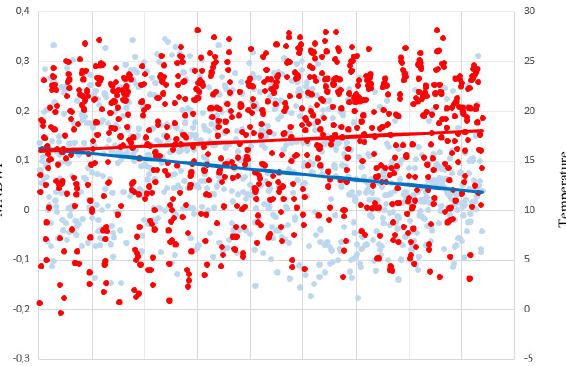
Figure 7. Statistical visualization of mean values acquired based on Landsat imagery during the 30 years for the city of Istanbul. (a) Relationship between temperature and NDVI, (b) the relationship between temperature and NDBI and (c) the relationship between temperature and